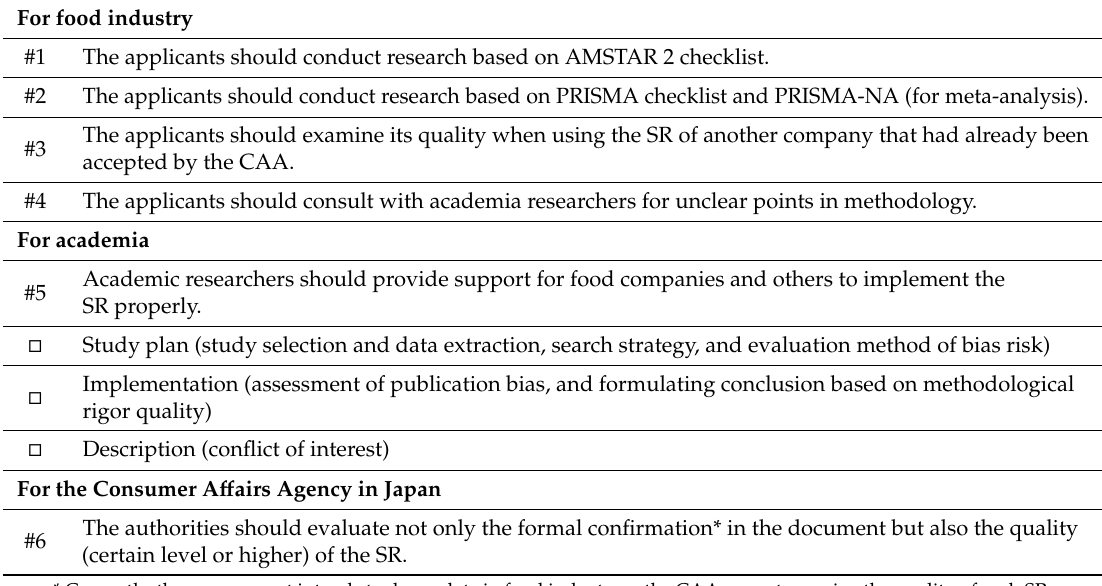
Table 4. Research challenge on systematic review of the foods with function